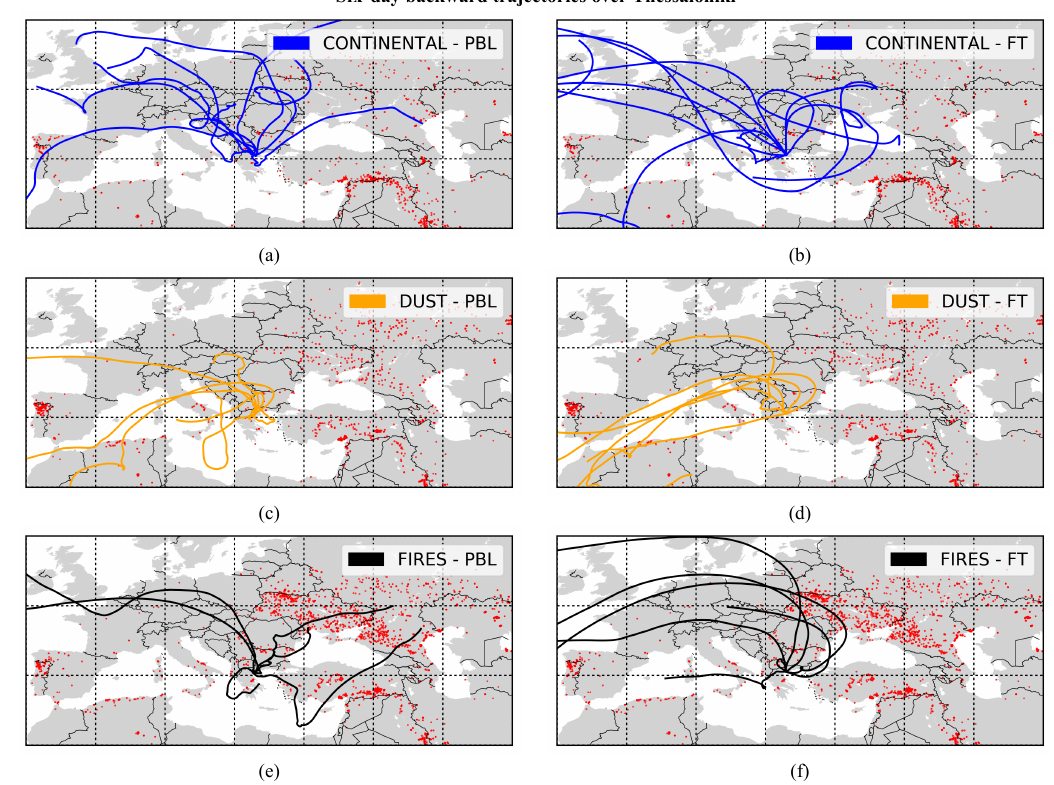
Figure 2. HYSPLIT 6-day backward trajectories and MODIS fire pixels for the continental (a, b) , desert dust (c, d) and biomass burning (e, f) cases in the period 2013–2015. The left column includes trajectories that arrive in the boundary layer, while the right column includes trajectories arriving in the free troposphere.